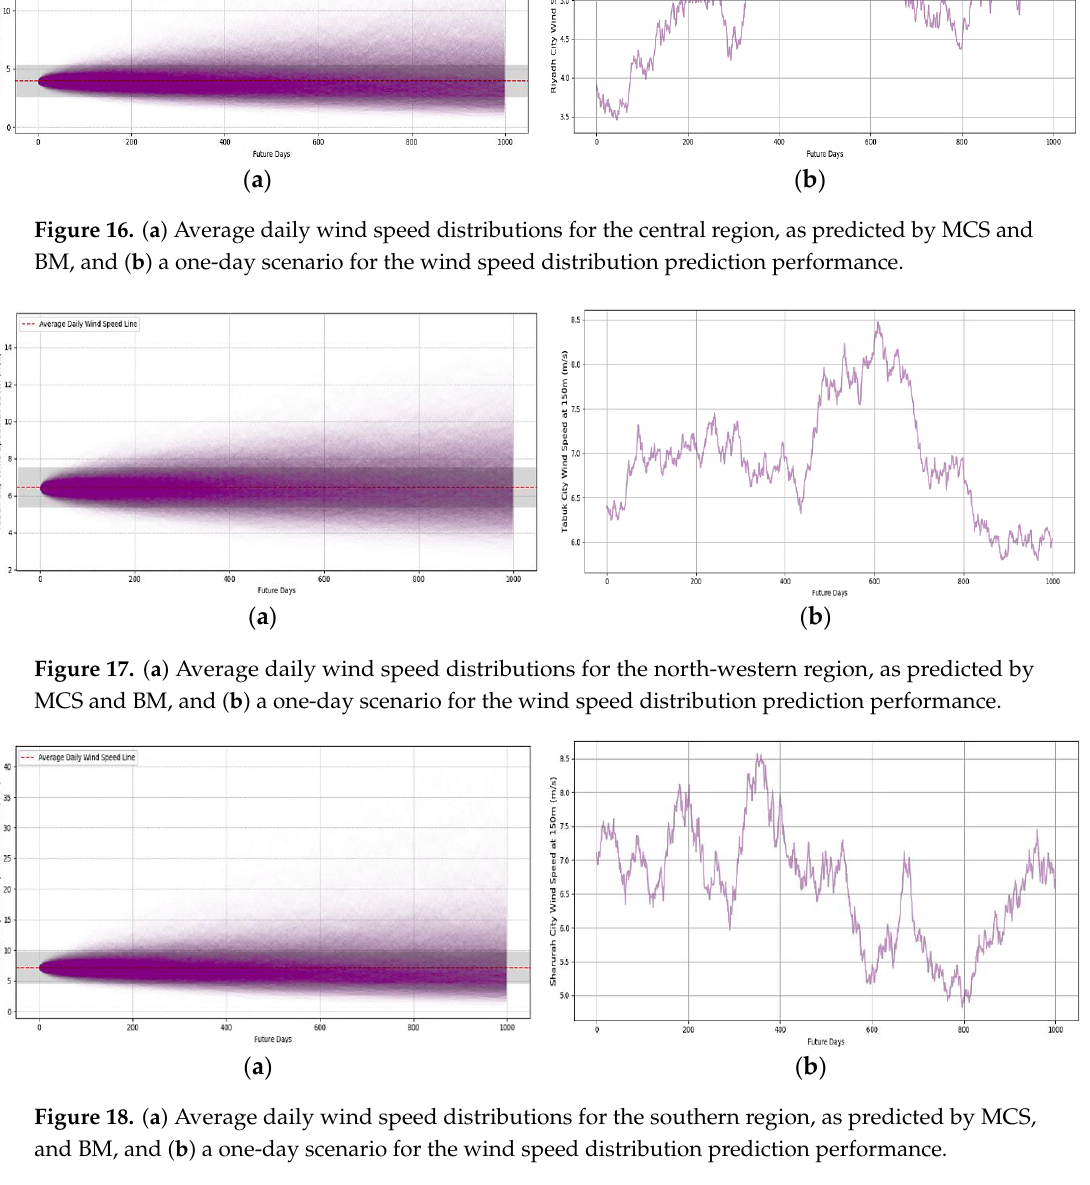
Figure 18. ( a ) Average daily wind speed distributions for the southern region, as predicted by MCS, and BM, and ( b ) a one-day scenario for the wind speed distribution prediction performance.